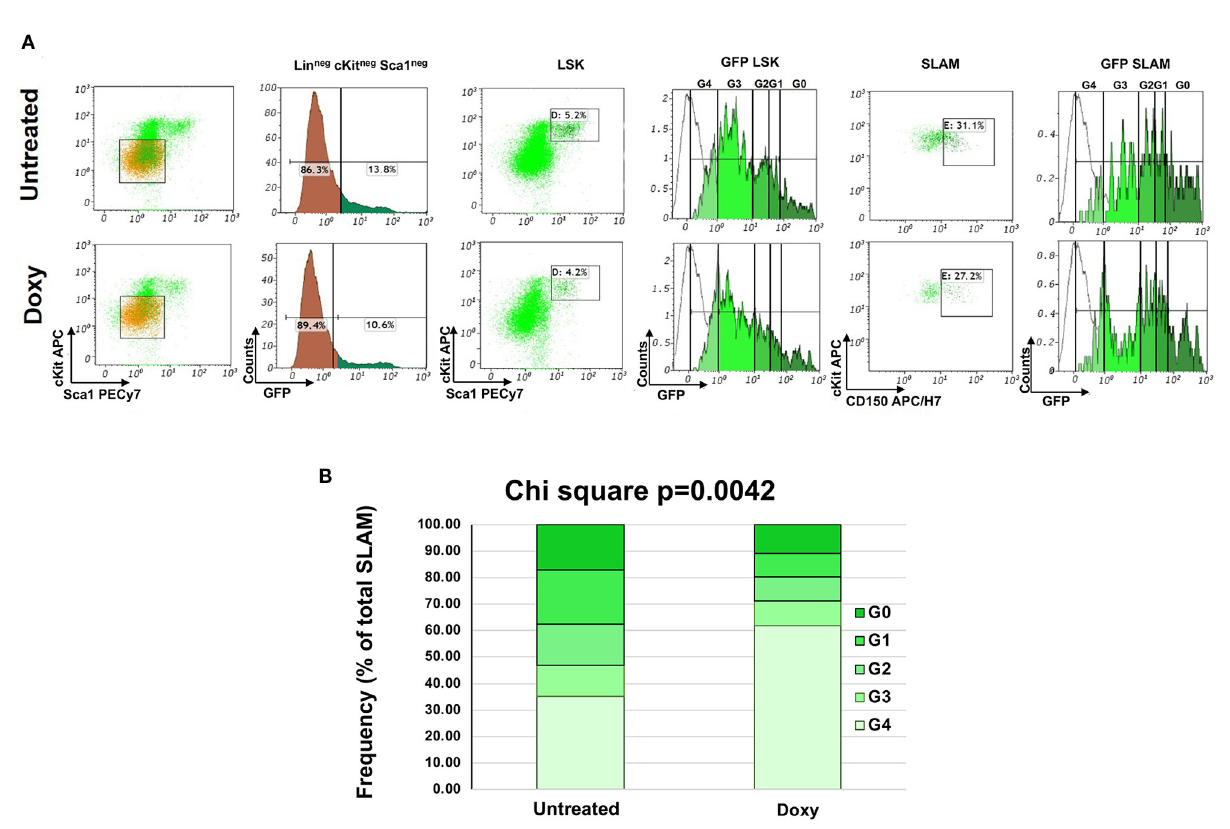
FIGURE1 FACS analyses of the hemi-decrement changes in GFP expression occurring in the HSC of the BM after 1 week of exposure to Doxy. (A) Representative FACS analyses of Lin-neg BM cells from double mutant mice (15-months old males) either untreated or exposed to Doxy for one week. The levels of GFP expressed by the Lin-neg cells are also presented as control. The levels of GFP expressed by the LSK and SLAM cells are divided into the G0, G1, G2. G3 and G4 gates, as reported (20). The gating used to define the LSK and SLAM populations are also indicated. The white lines indicate the levels of GFP expressed by the BM cells from a single TetO-H2BGFP transgenic mouse, used as negative control. The total number of events analyzed is 10,000 per sample which correspond to 500 LSK cells (5% of 10,000 events) and 155 SLAM cells (31% of 500 cells) for the untreated group and to 420 LSK cells (4.2% of 10,000 events) and 114 SLAM cells (27.2% of 500 cells) for the Doxy group. (B) Percentage of cells in the various GFP classes over the total frequency of SLAM cells in the BM of untreated or Doxy treated-mice. Data are presented as mean of those observed in three mice per group. The distribution of the cells among the classes in the two groups is statistically significant by Chi-Square test. The statistical analyses of the differences within each class is reported in Supplementary Figure